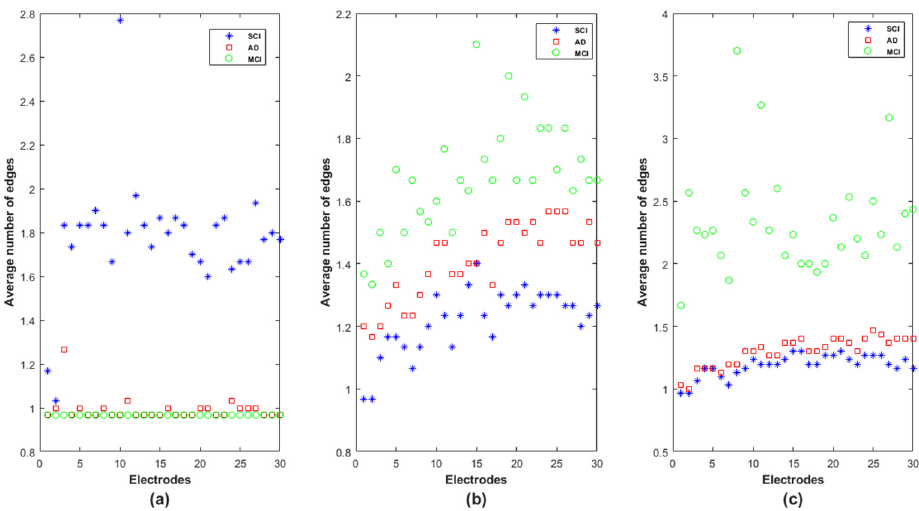
Figure 11. Average number of edges in the shortest path at each node for SCI, MCI and AD on the ( a ) delta, ( b ) alpha, and ( c ) beta bands. ( a ) delta, ( b ) alpha, and ( c ) beta